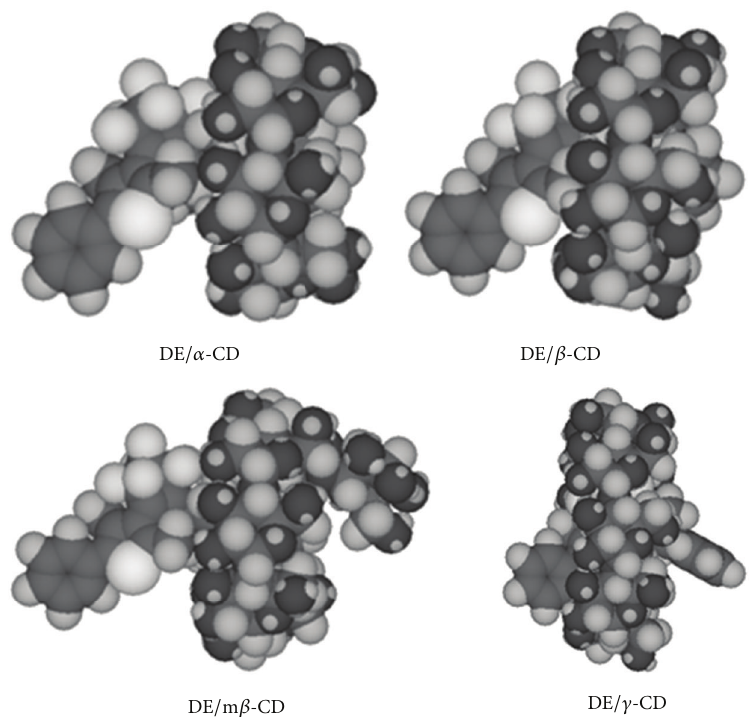
Figure 2: Minimum-energy structures of DE/CD complexes calculated by